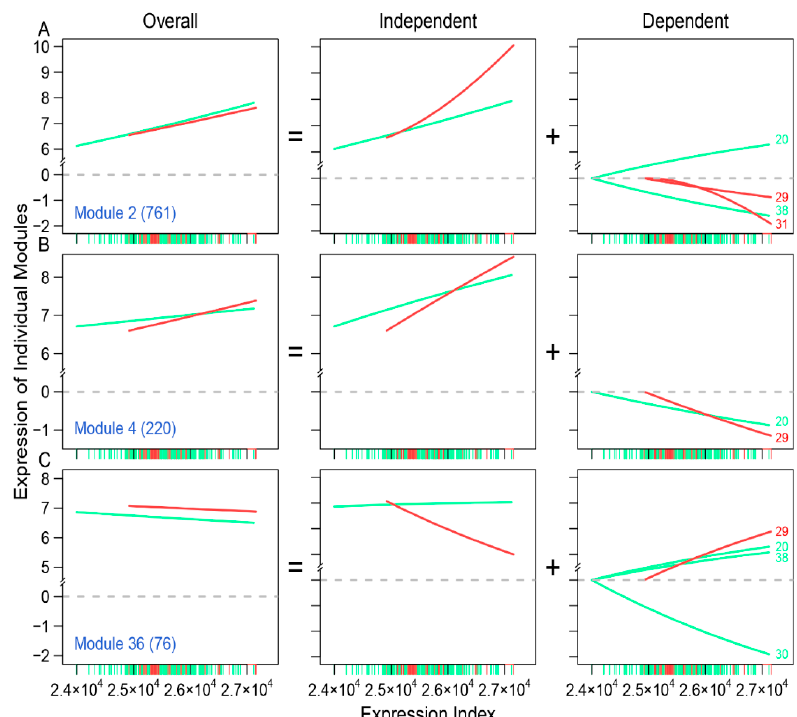
Figure 5. Decomposition of the overall expression level of three selected modules, 2 ( A ), 4 ( B ), and 36 ( C ), as regulated genes, into its independent and dependent components in low-risk (red) and high-risk patients (green). The dependent components of a regulated gene are determined by regulators with names given at the end of lines.